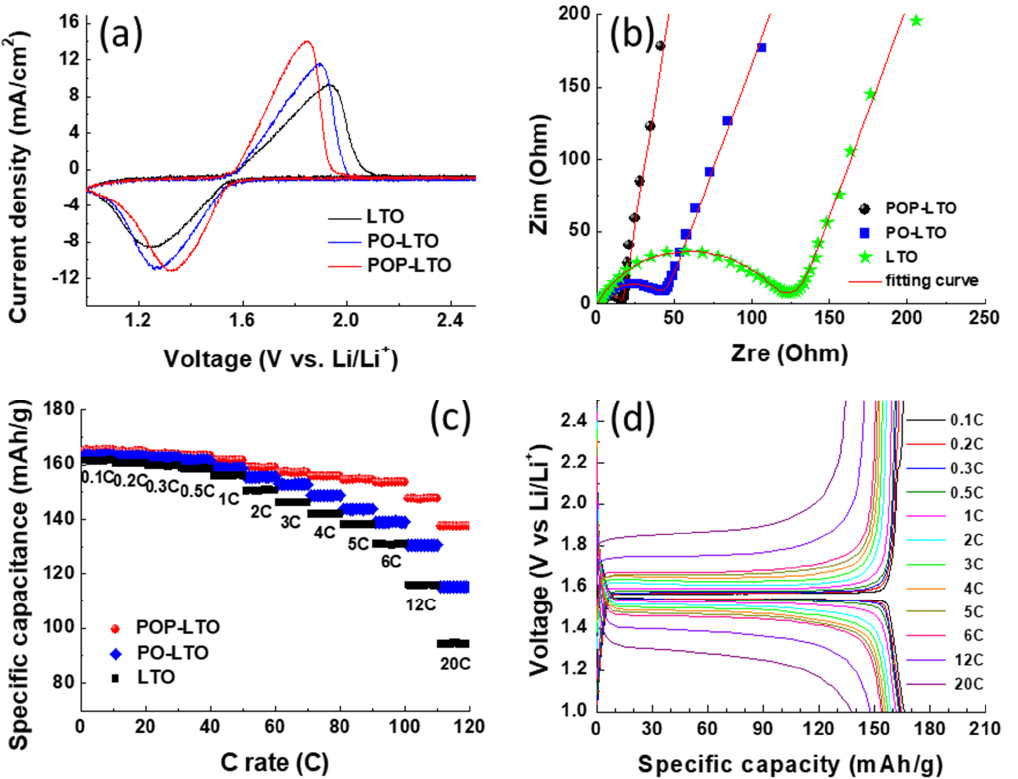
Figure 7. ( a ) The cyclic voltammetry (CV) curves of bare LTO, PO-LTO and POP-LTO stepped between 1.0 and 2.5 V with a scan rate of 1 mV/s; ( b ) Nyquist plots of bare LTO, PO-LTO and POP-LTO in the frequency range of 10 5 Hz to 10 − 2 Hz; ( c ) rate capability of the as-prepared samples at C rates between 0.1 C and 20 C; ( d ) the corresponding charge/discharge profile of the POP-LTO with various C rates.